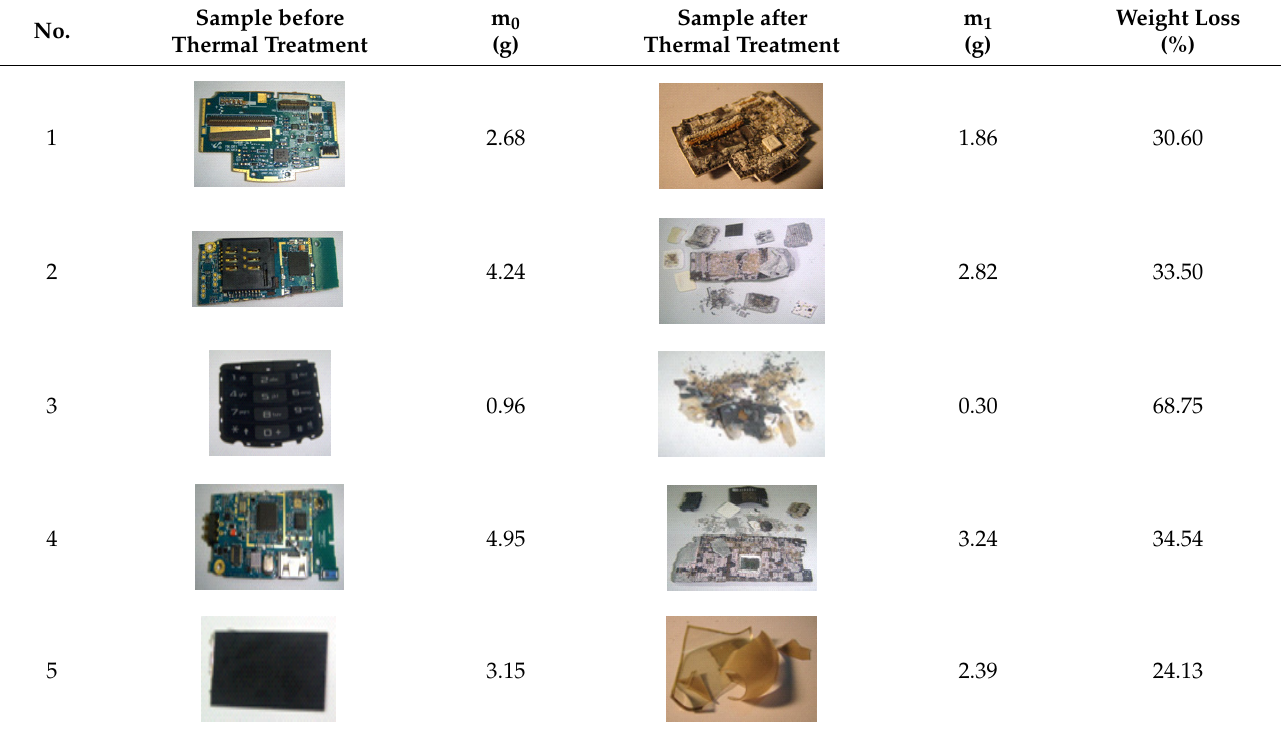
Table 2. Samples of the mobile phone waste 1 to 11 before and after thermal treatment in the fluidised bed and their weight losses.